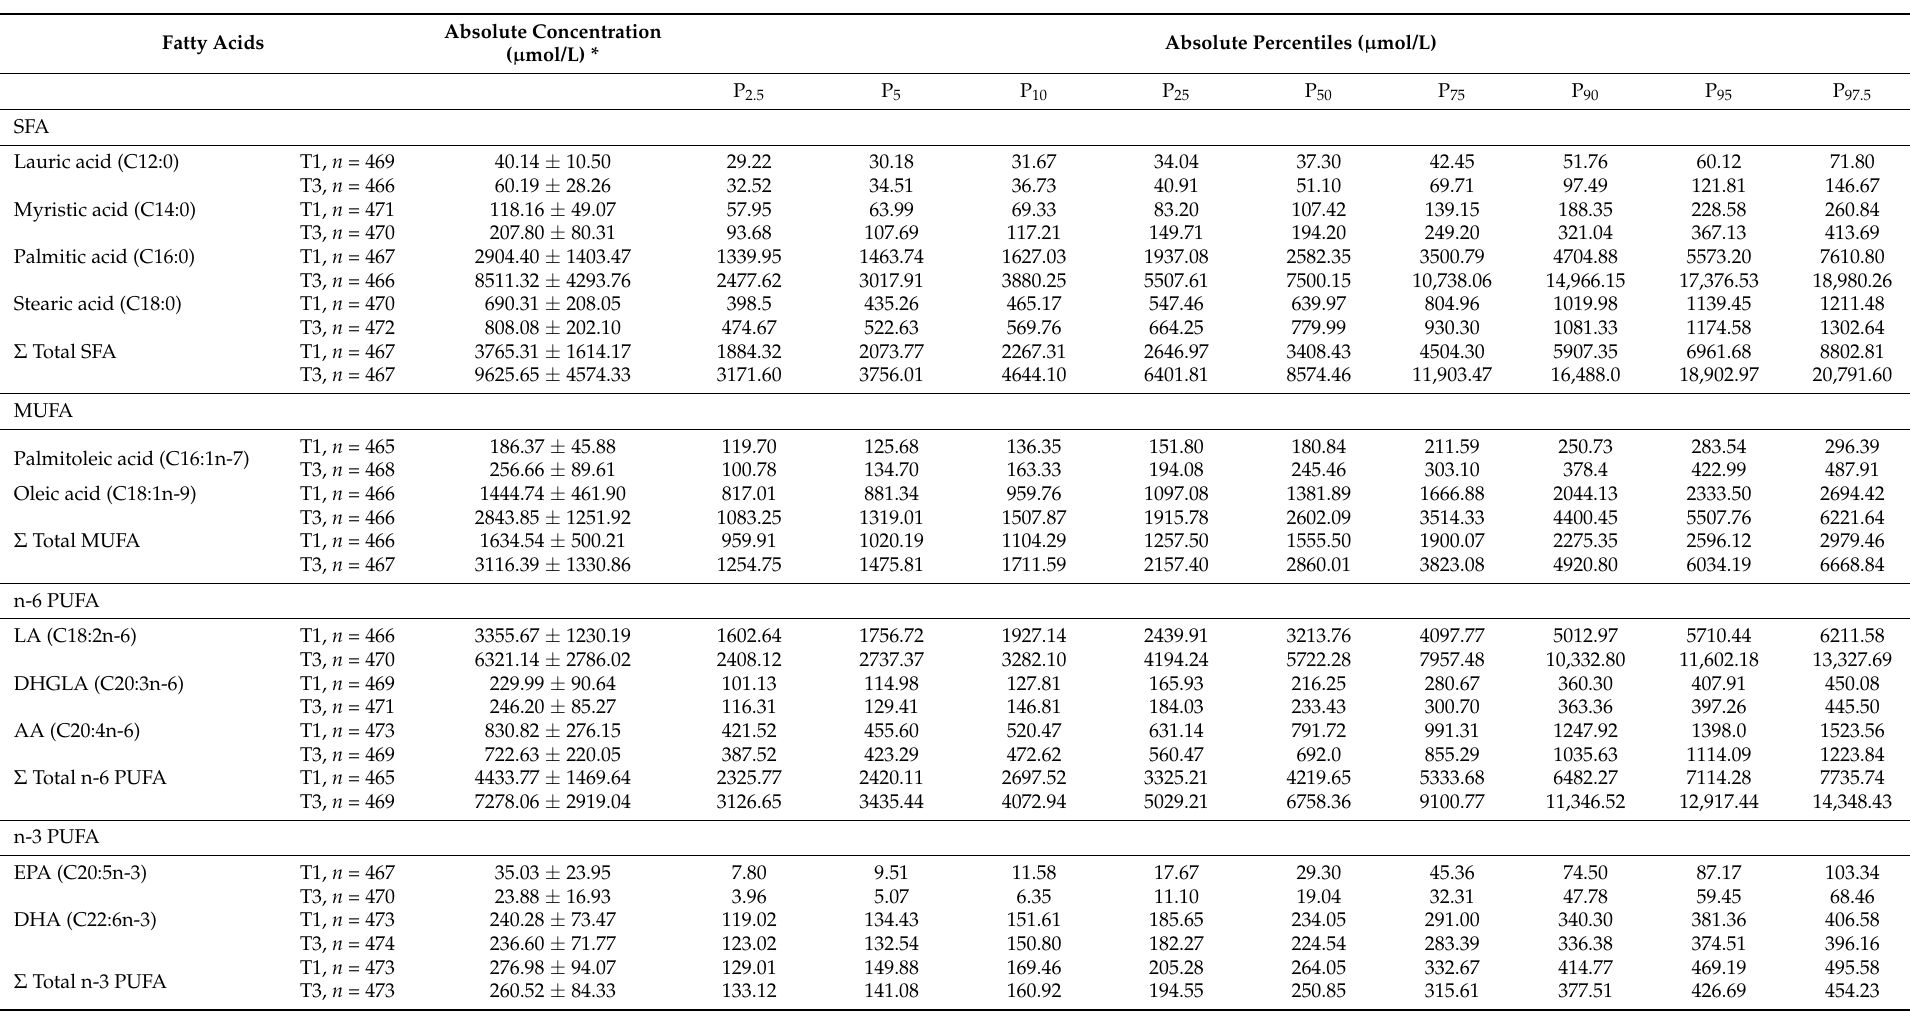
Table 2. Absolute concentration and percentile ( µ mol/L) distribution of fatty acid in maternal serum during the first (T1) and third (T3) trimesters of pregnancy. Fatty